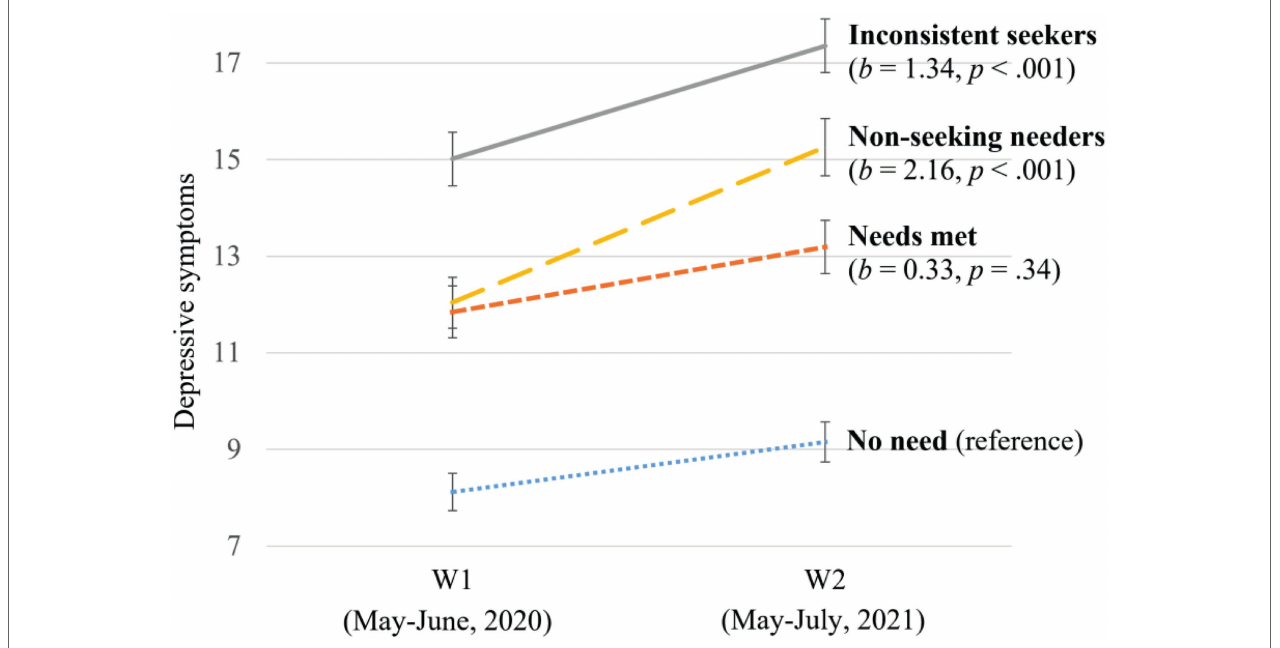
FIGURE 1 | Changes in parents’ depressive symptoms between waves by help-seeking group. The coefficient ( b s) and corresponding p -values indicate how the changes in depressive symptoms in the three groups differed from the reference group after controlling for covariates. The error bars indicate 95% CIs of symptom